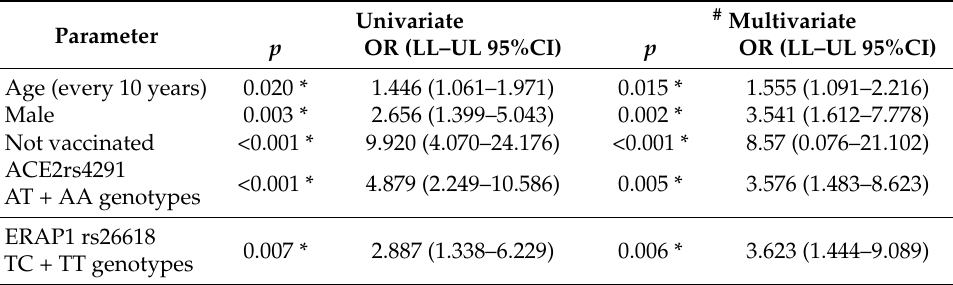
Table 6. Univariate and multivariate logistic regression analysis for the studied parameters affecting severe from mild (n = 80 vs.